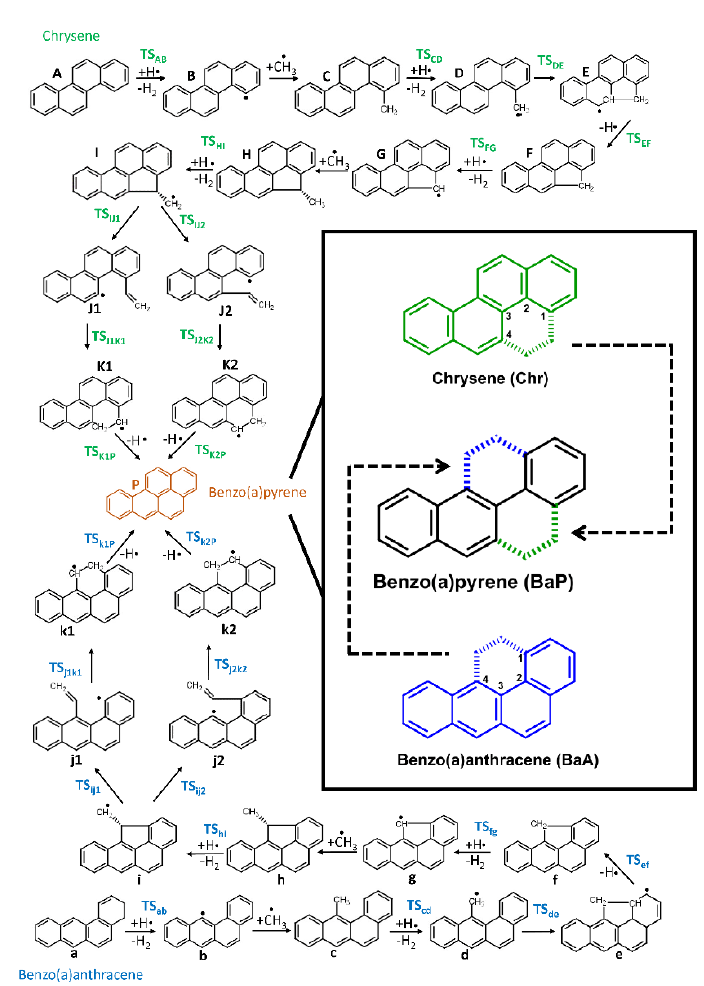
Figure 2. Reaction pathways of the formation of benzo(a)pyrene (” P ”) starting from chrysene (” A ”) or benzo(a)anthracene (” a ”). 2D structures of chrysene, benzo(a)pyrene, benzo(a)anthracene are highlighted along with the carbon atoms, which were involved in the new ring formations.